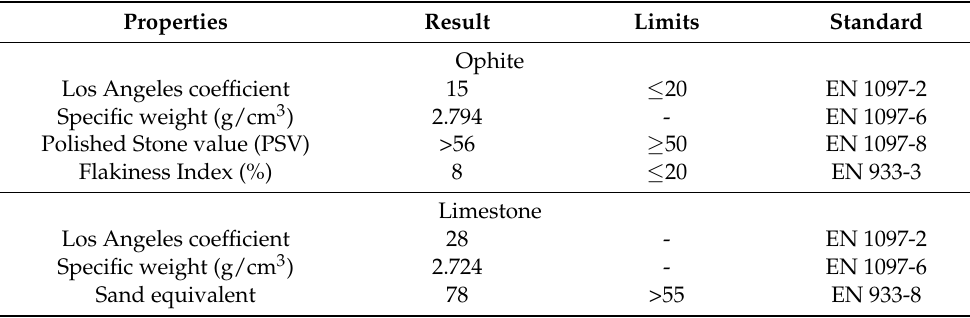
Table 1. Properties of aggregates.